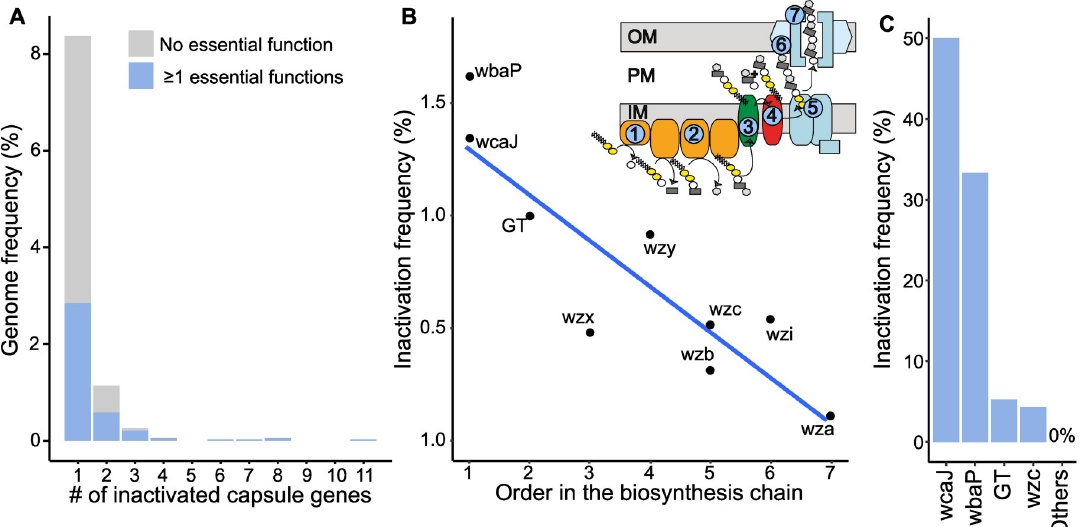
Fig 3. Loss of function in the capsule locus. (A) Distribution of the number of inactivated capsule genes per genome, split in 2 categories: loci lacking a functional essential capsule gene (blue, non-capsulated strains), and other loci only lacking nonessential capsule genes (white, not categorized as non-capsulated strains) (https://doi.org/10.6084/m9.figshare.14673153). (B) Linear regression between the inactivation frequency and the rank of each gene in the biosynthesis pathway ( p = 0.001, R 2 = 0.78). The numbers in the scheme of the capsule assembly correspond to the order in the biosynthesis pathway (https://doi.org/10.6084/m9.figshare.14673153). (C) Frequency of inactivated capsule genes arising in the non-capsulated clones isolated in 8 different strains after approximately 20 generations in LB growth medium. Genomes containing several missing genes and pseudogenes are not included (https://doi.org/10. 6084/m9.figshare.14673177). GT, glycosyl transferases; LB, Luria–Bertani.